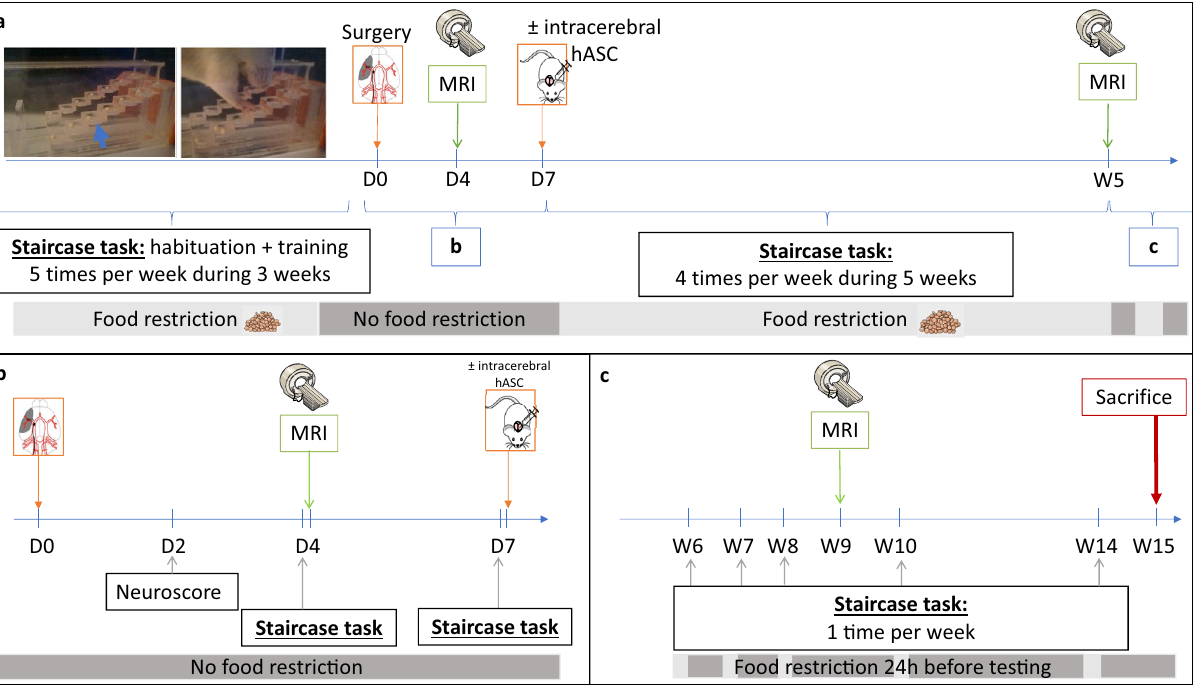
Figure 1. Study design. ( a ) Experimental design; ( b ) focus on the first week of the experiment; ( c ) focus on weeks 6 to 15: extended follow-up only for rats with corticostriatal lesions. D days, MRI magnetic resonance imaging, hASC human adipose mesenchymal stem cells, W